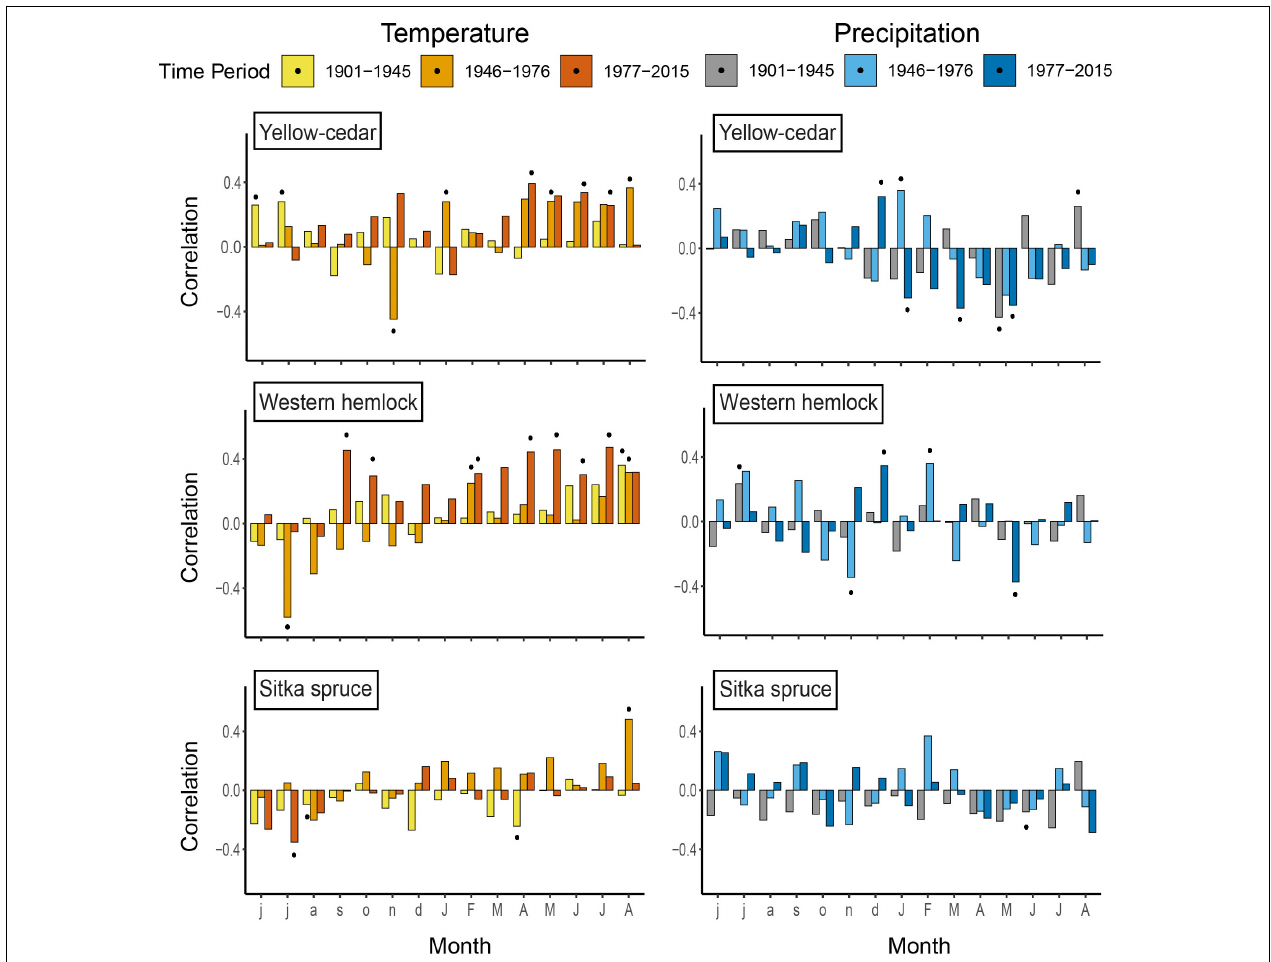
FIGURE 4 | Pearson correlation functions relating each species residual chronology to monthly maximum temperature and total precipitation across each time period. Bars above the line represent a positive correlation to monthly maximum temperature/total precipitation, and bars below the line represent a negative correlation to monthly maximum temperature/total precipitation. Symbols indicate significant correlations ( p <